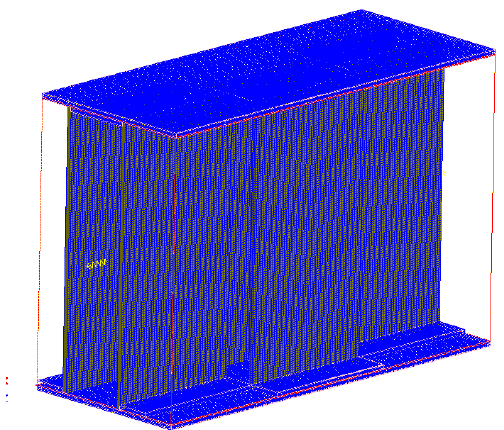
Figure 2. Mesh diagram of model.